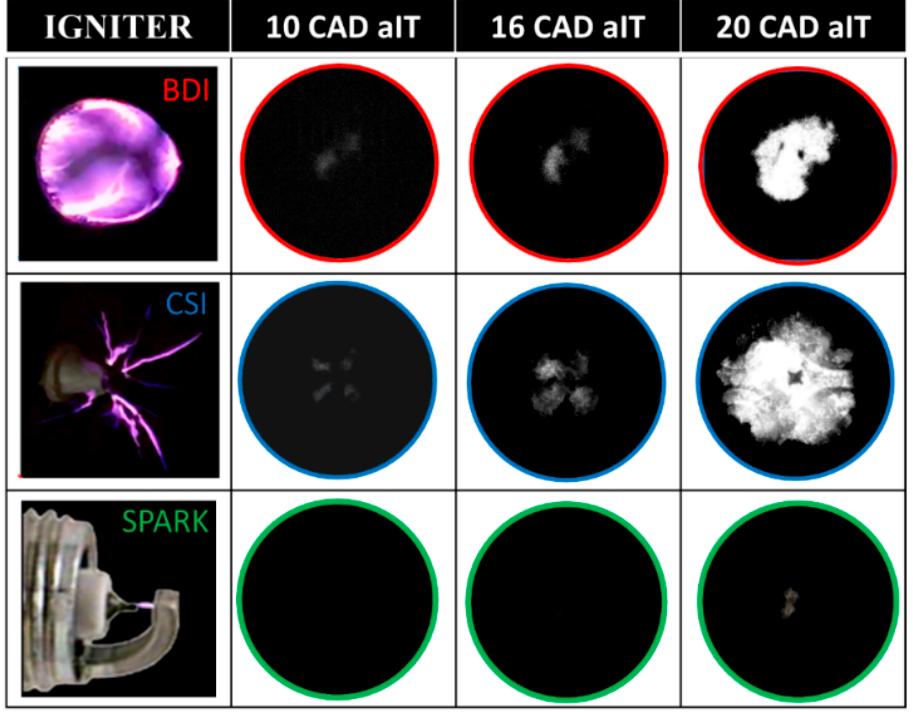
Figure 4. Representation of the flame front evolution in the first instant after the end of the discharge